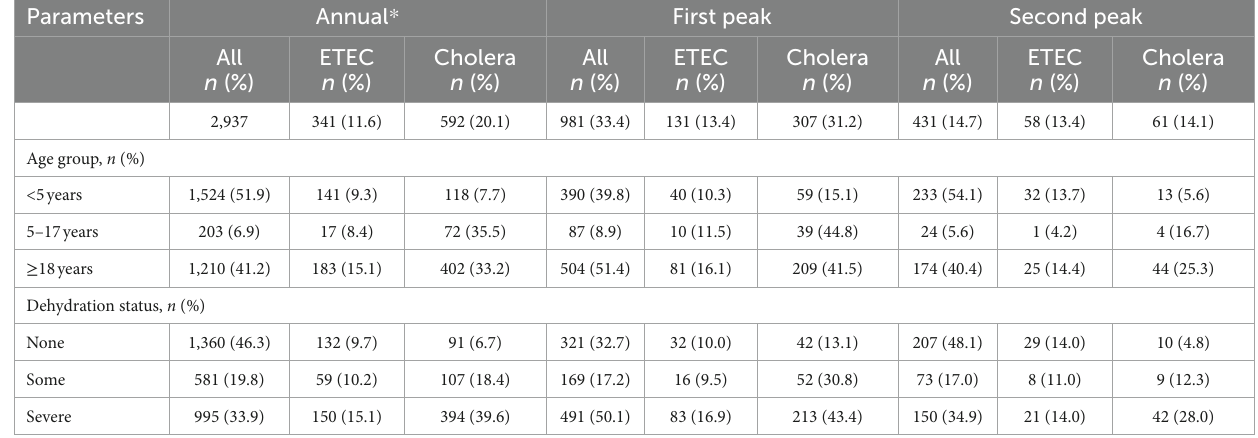
TABLE 1 Distribution of demographic and clinical characteristics of V. cholerae and ETEC according to peak (First peak – March to April; Second peak – October to November).